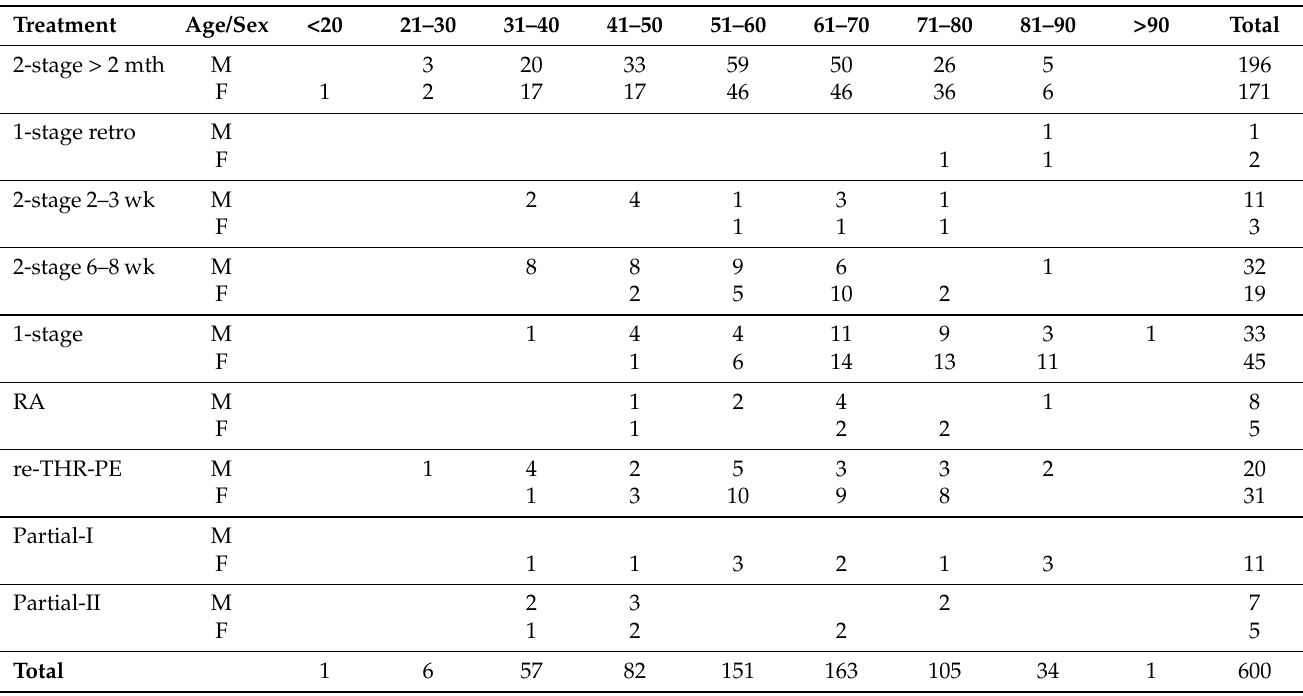
Table 1. Demographic characteristics of study